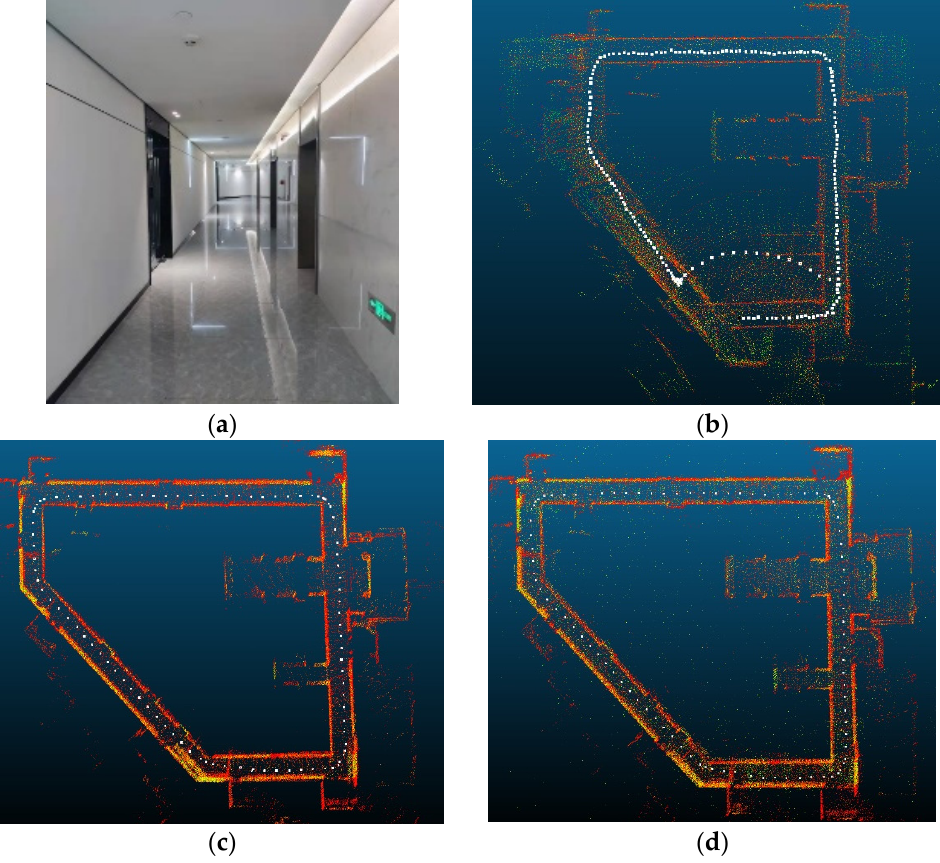
Figure 7. ( a ) Corridor scene for experiment 1. ( b ) Mapping results of LeGO-LOAM in the corridor scene, with the mapping of LeGO-LOAM having a significant deviation and the structure incomplete. ( c ) Mapping results of LIO-SAM in the corridor scene, with LIO-SAM having a complete mapping structure but lacking information on the top and ground. ( d ) Mapping results of HSDLIO in the corridor scene, with HSDLIO having a complete mapping structure.